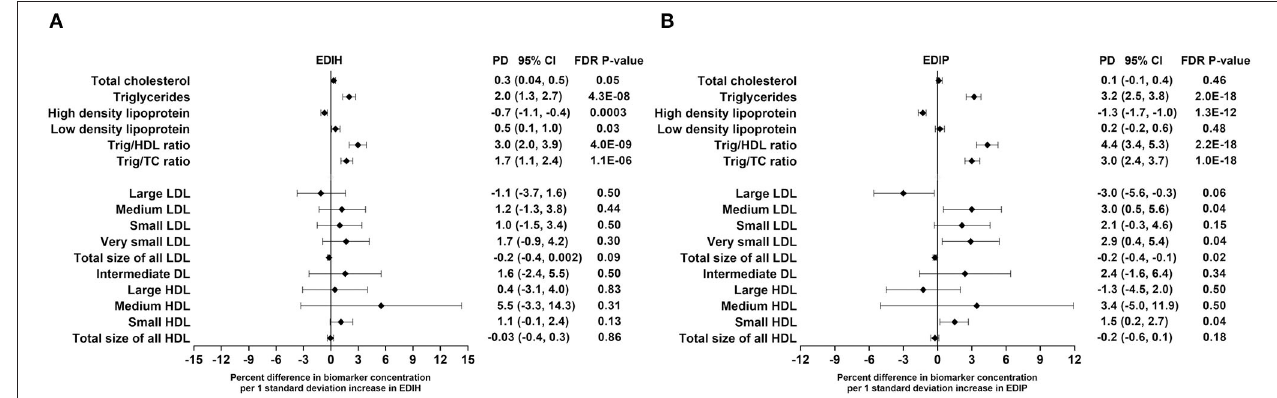
FIGURE 4 | Percentage difference (PD—beta coefficients) (95% confidence intervals) in lipid and lipid particles biomarkers biomarker per 1 standard deviation increment in EDIH (A) and EDIP (B) in the Women’s Health Initiative. Biomarkers were log transformed using natural logs. Values were obtained via multivariable-adjusted linear regression models adjusted for the following variables: total energy intake, BMI-continuous, age, total recreational physical activity, pack years of smoking; number of supplements used; fasting status at blood draw, race/ethnic groups, educational levels, regular use of NSAID, statins, unopposed estrogen and/or estrogen plus progesterone hormones, hormone therapy (HT) study arms. The sample sizes for each biomarker were as follows: total cholesterol (TG), 21,378; triglycerides (TC), 18,833; high-density lipoprotein (HDL), 20,508; low-density lipoprotein (LDL), 16,525; TG/HDL ratio, 17,761; TG/TC ratio, 18,631; large LDL, 1,653; medium LDL, 1,356; small LDL, 1,653; very small LDL, 1,356; total size of all LDL, 1,652; intermediate density lipoprotein, 1,653; large HDL, 1,653; medium HDL, 1,241; small HDL, 1,653; total size of all HDL,